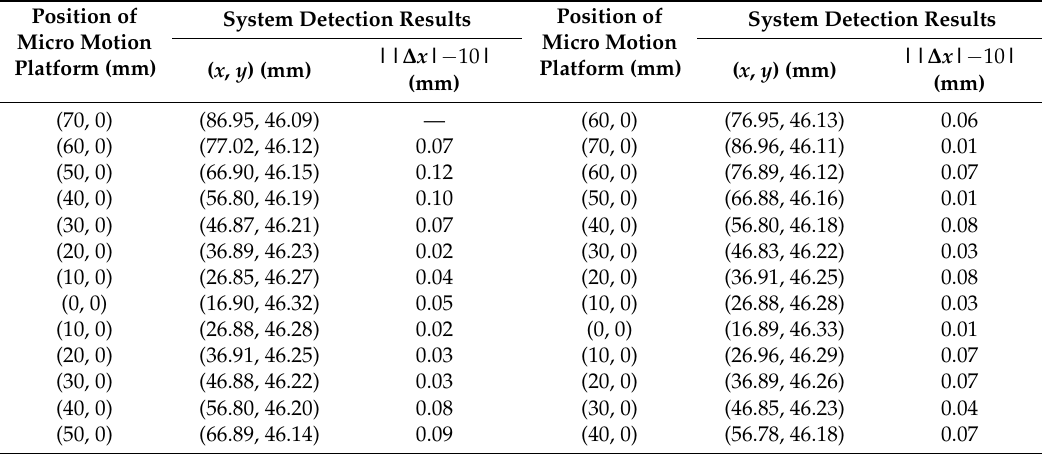
Table 4. Repeatability accuracy test experimental data.